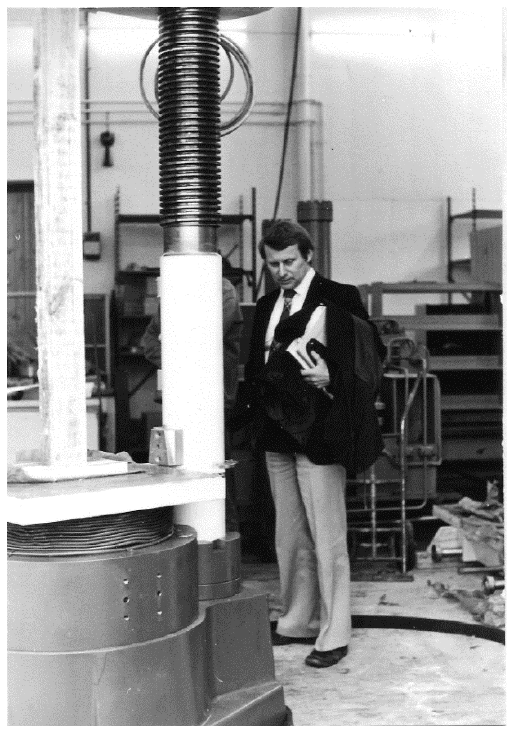
Figure 4. Prof. Vollstädt and his biggest press at that time.